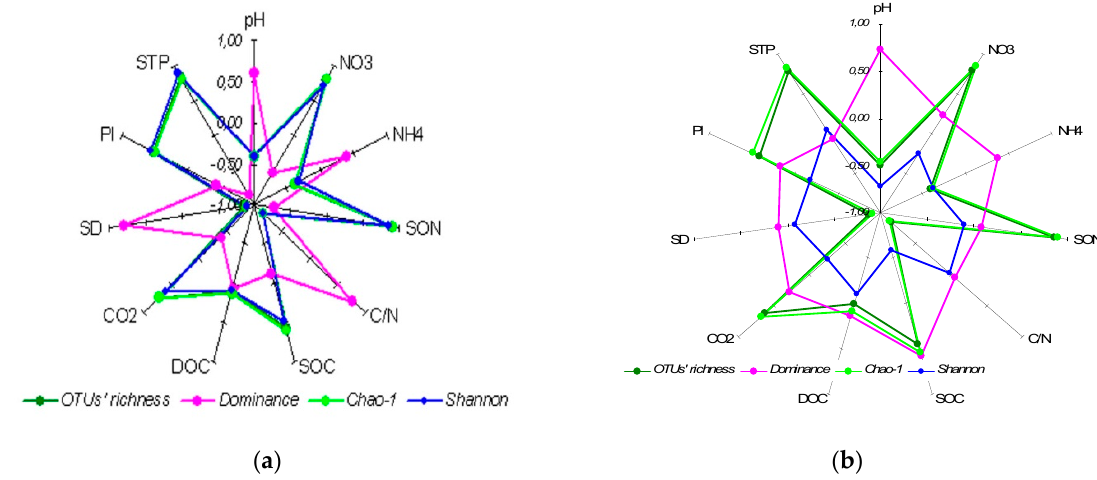
Figure 6. Correlation coefficients (Spearman’s) between soil properties and bacterial ( a ) and fungal ( b ) α -biodiversity indices. The coefficients exceeding │ 0.51 │ are statistically significant at p ≤ 0.05 level. Abbreviations used for soil properties: